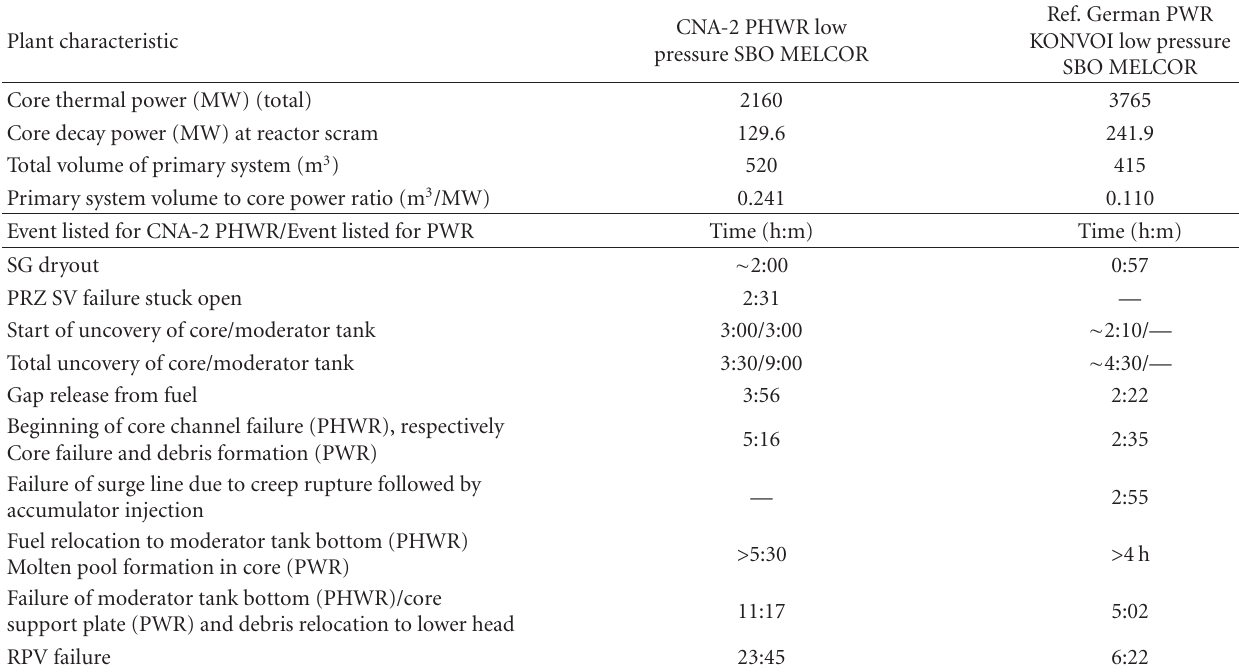
Table 2: CNA-2 PHWR NPP versus German PWR—timing of events in an SBO. Plant